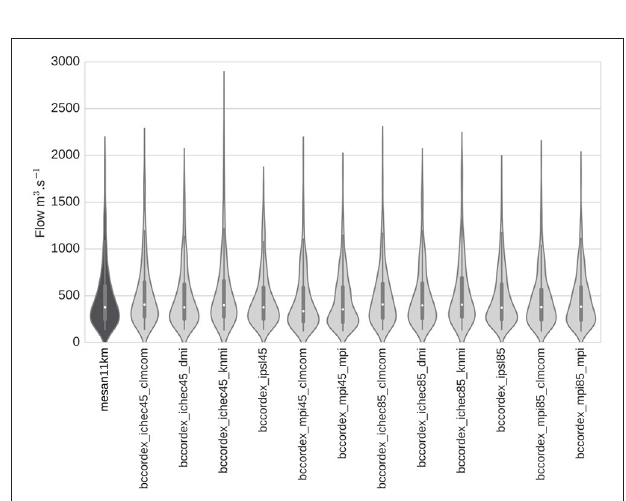
FIGURE 3 | Mean decadal total streamflow calculated using the MESAN reanalysis and the 12 BCCORDEX climate projections at the outlet of the Seine River for